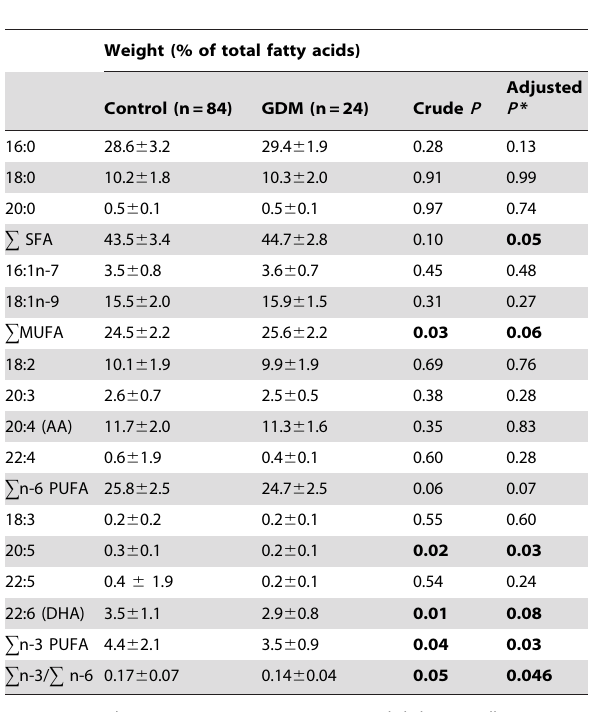
Table 2. Cord plasma fatty acids in newborns of mothers with versus without gestational diabetes mellitus.